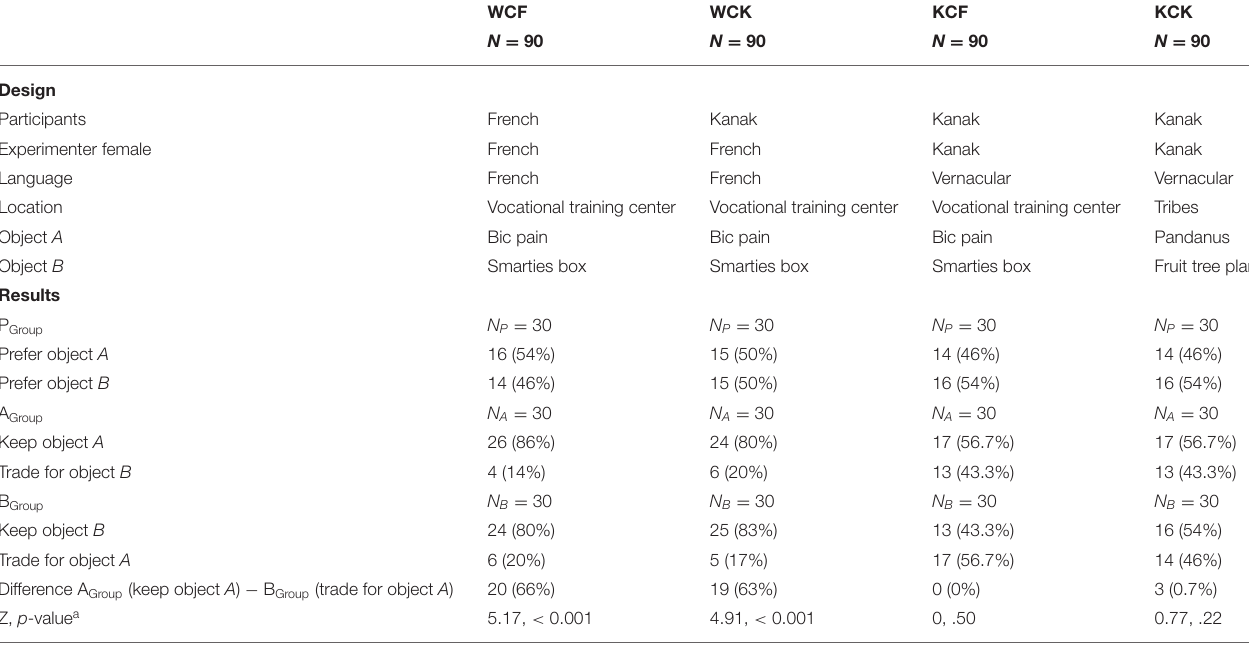
TABLE 1 | Design features and results for the four conditions ( N =